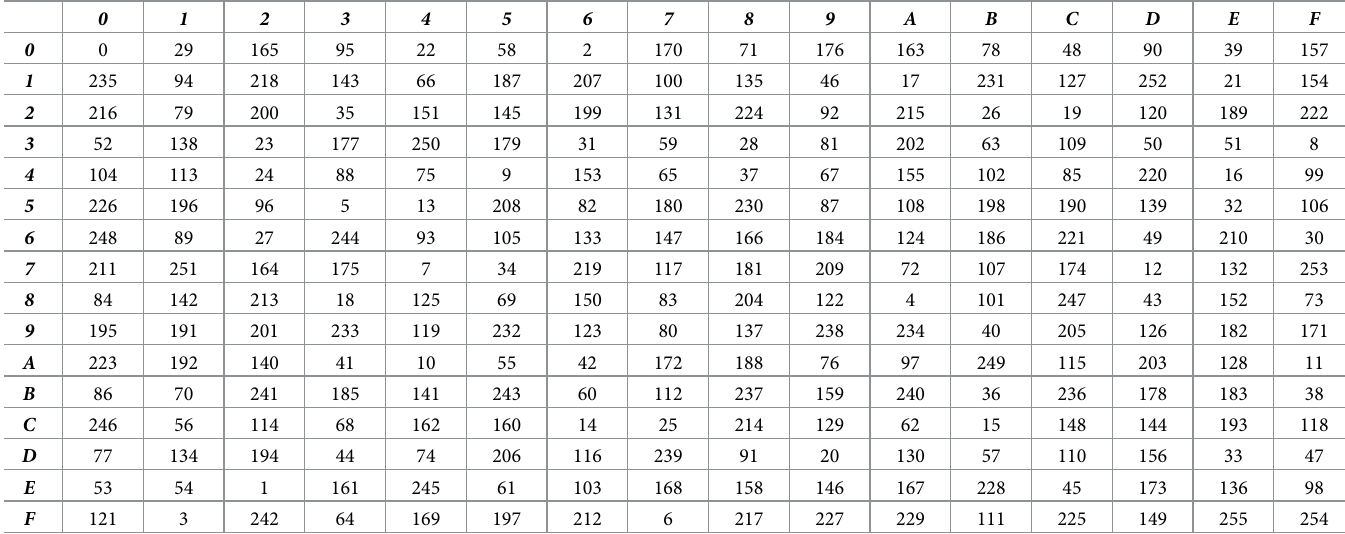
Table 6. Proposed S-box (S5) in 16 × 16 matrix form—Generated with T 5 .